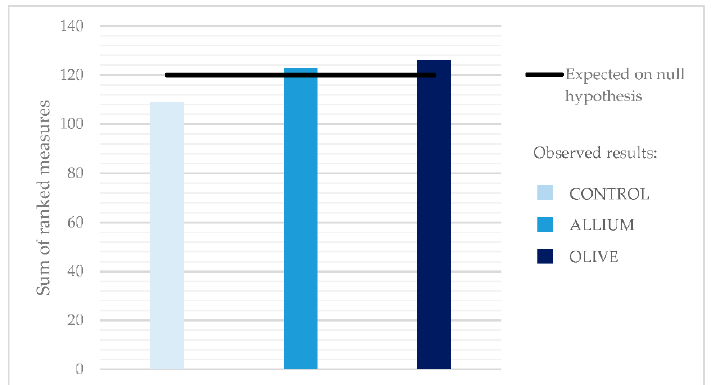
Figure 1. Rank-ordered results of consumer preference (by decreasing order from 1 to 3) for the treatments obtained in the ranking test (n = 60). Results are expressed as the sum of rank scores of consumers ( p > 0.05 based on Friedmans test).